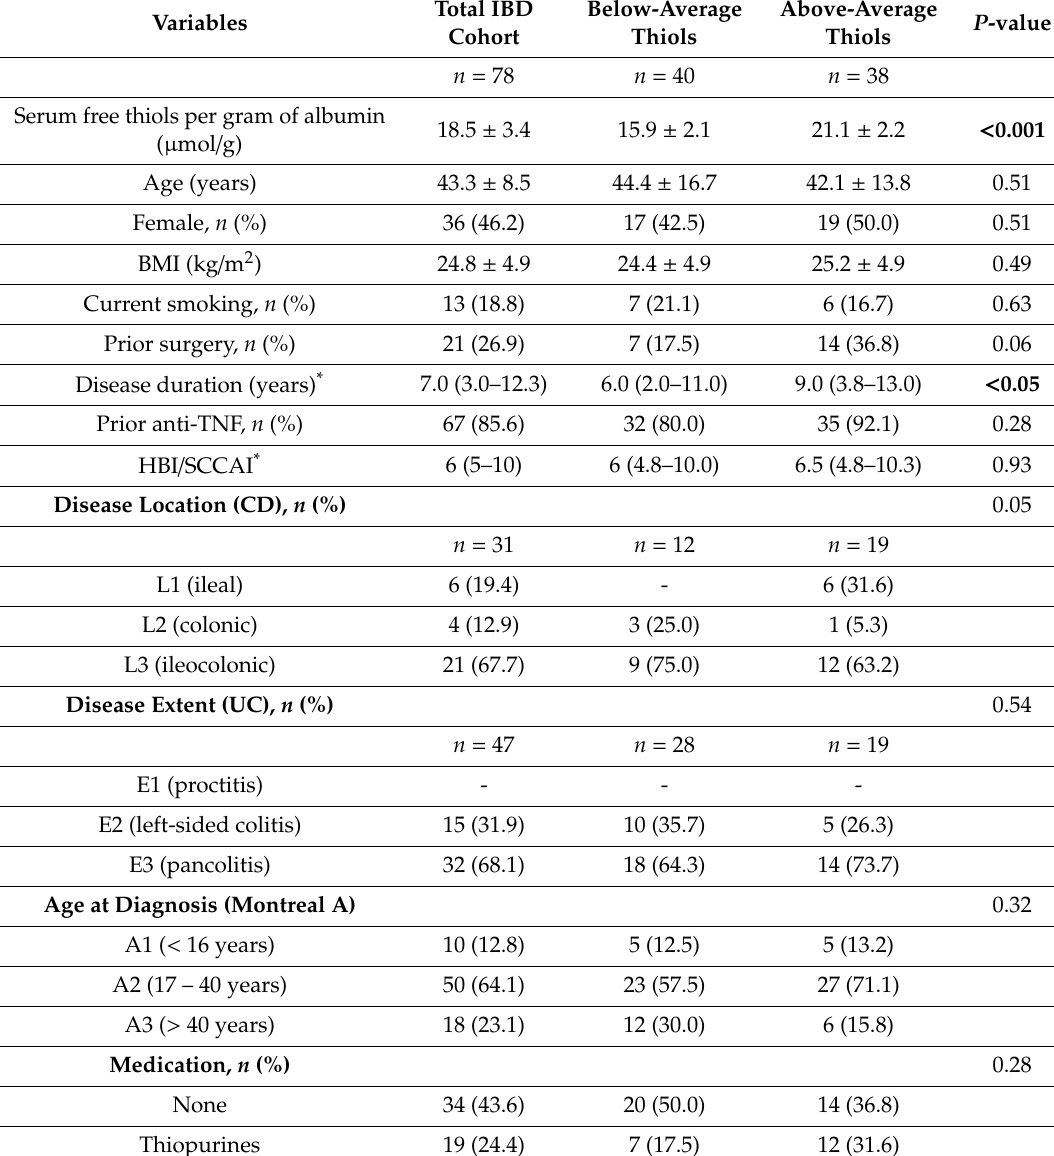
Table 2. Baseline demographic, clinical and IBD-specific characteristics compared between above- and below-average albumin-adjusted serum free thiol concentrations (average: 18.5 ± 3.4 µ mol / g). Total IBD Below-Average Variables Cohort